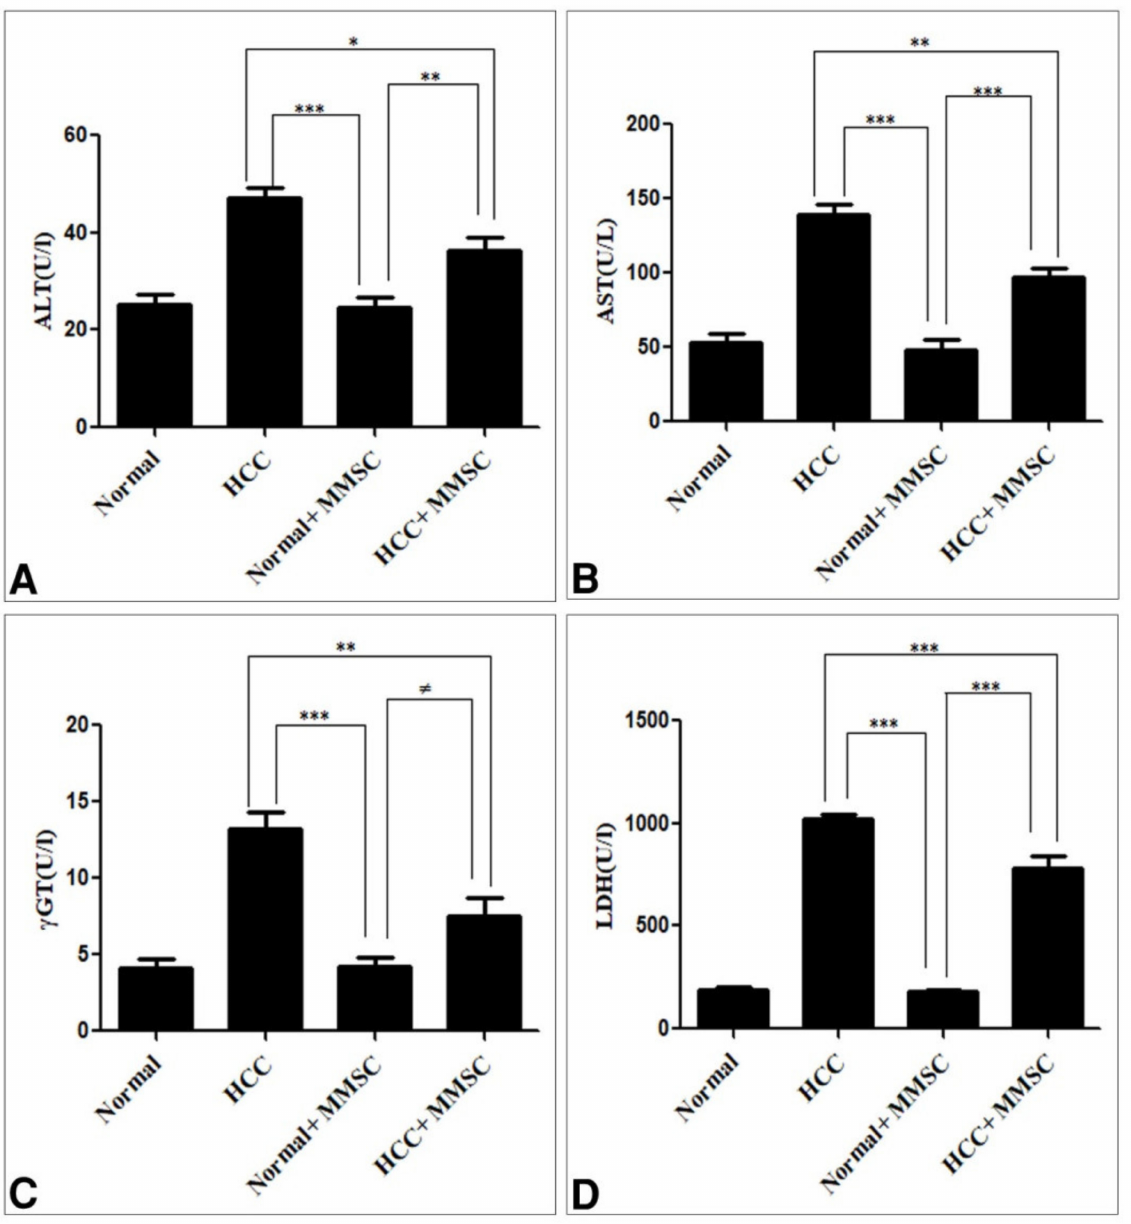
Figure 1. The serum level of ( A ) alanine transaminase (ALT), ( B ) aspartate aminotransferase (AST), ( C ) gamma glutamyl- transferase ( γ GT), and ( D ) lactate dehydrogenase (LDH). Data were presented as mean ± SEM. * Significantly different at p < 0.05 using ANOVA followed by Bonferroni’s as a post-hoc test, ** Significantly different at p < 0.001, *** Significantly different at p < 0.0001, (cid:54) = no significantly difference using ANOVA followed by Bonferroni’s as a post-hoc test. Hepatocellular carcinoma (HCC), S-methylmethionine sulfonium chloride